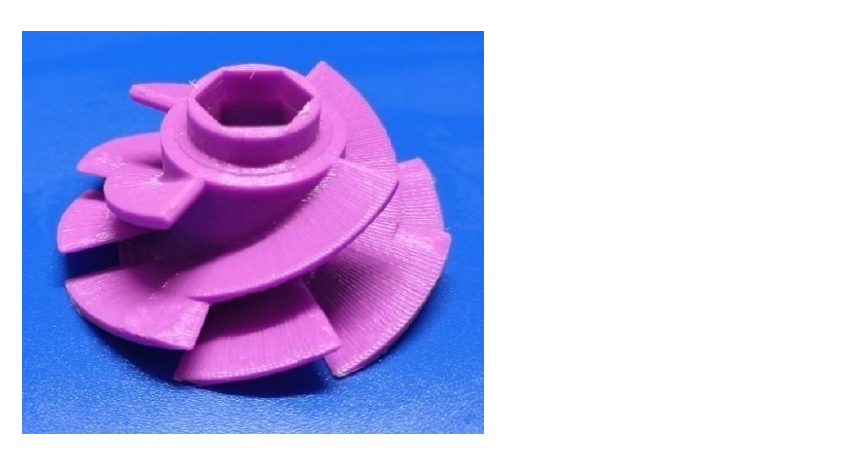
Figure 15. Guiding device prototype of the new hybrid labyrinth pump. Source: authors’ development.